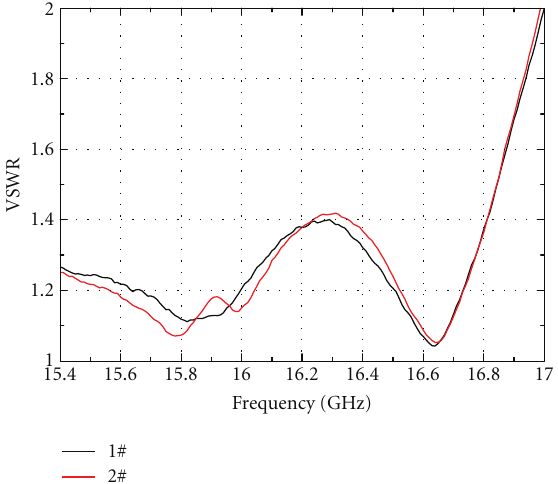
Figure 12: The VSWR of the high integrate broad-band microstrip antenna array using MPCB technology.